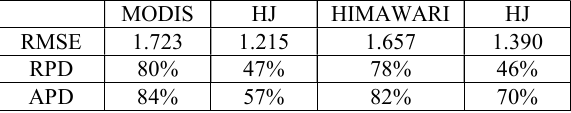
Table 5. Comparison of the accuracy of the inversion results of the Modis-Aqua product, the Himawari product and the HJ